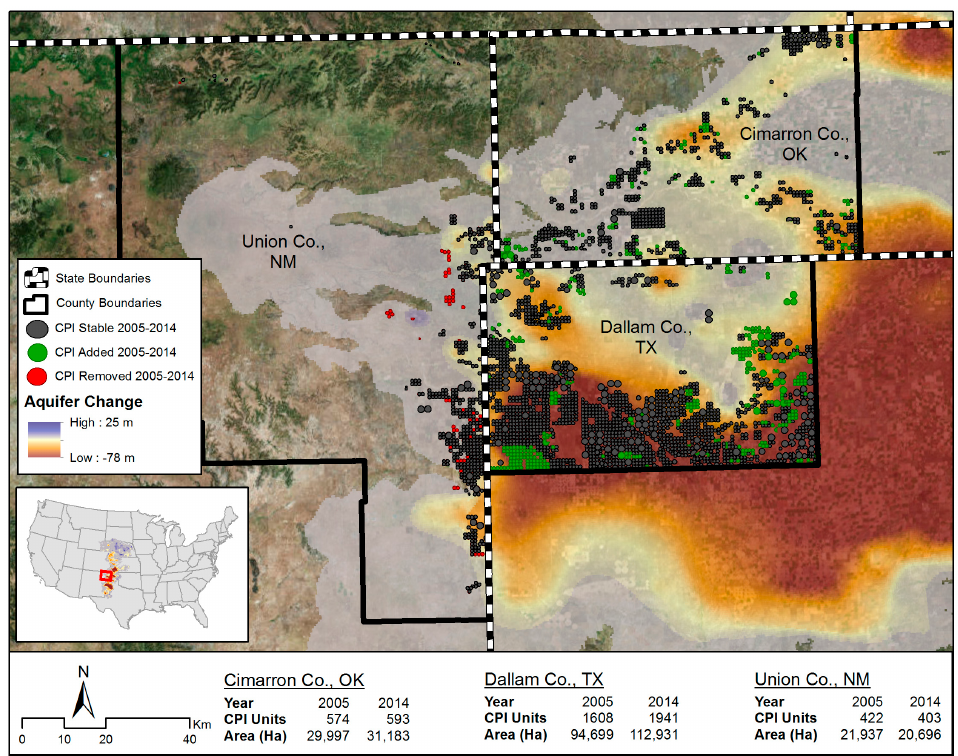
Figure 5. Center pivot irrigation (CPI) in the tri-state area showing areas added and removed between 2005 and 2014 overlain on the High Plains Aquifer change (presettlement to present) map. Source: Figure created by the authors using aquifer data obtained from the U.S. Geological Survey